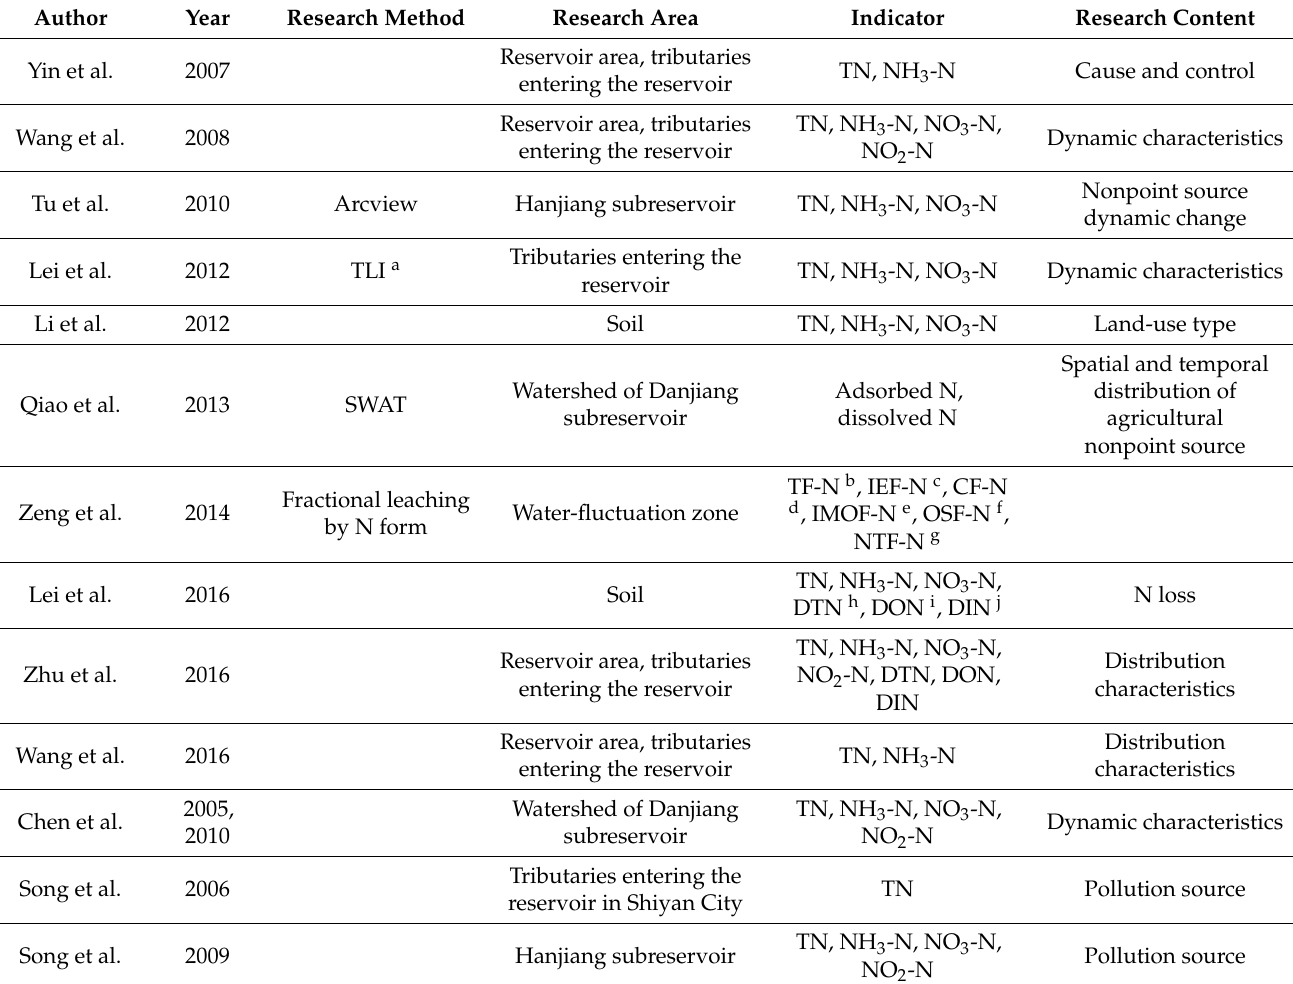
Table A1. Research on N in Danjiangkou reservoir and upper